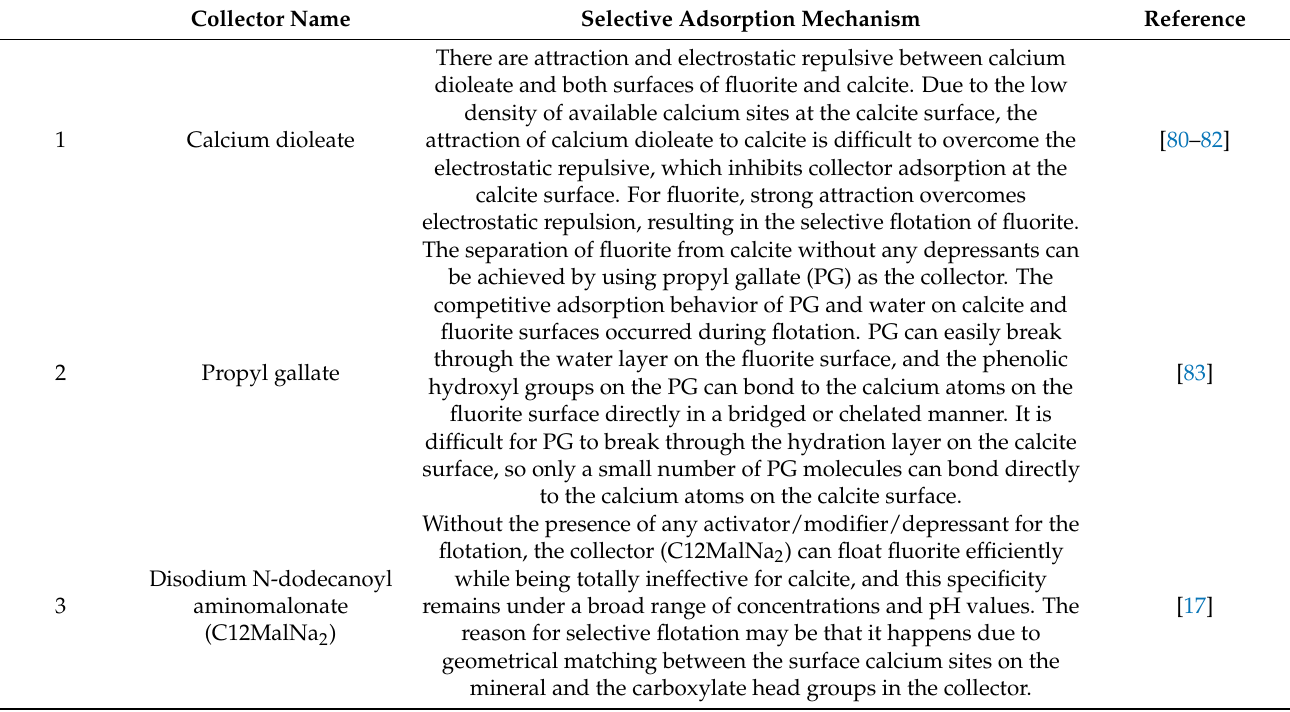
Table 3. Organic compound collectors for selective separation of fluorite from